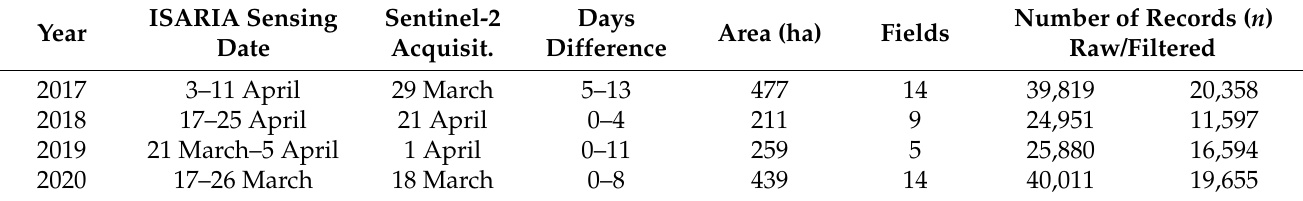
Table 1. Field experiment overview.